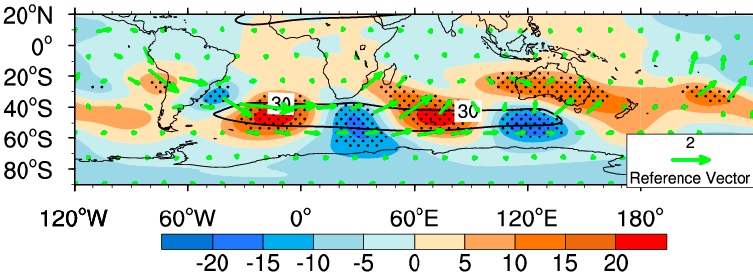
Figure 5. As in Figure 2a, but for anomalies of geopotential height at 200 hPa (shading, unit: gpm) and related wave-activity flux (vector, unit: m 2 s –2 ).